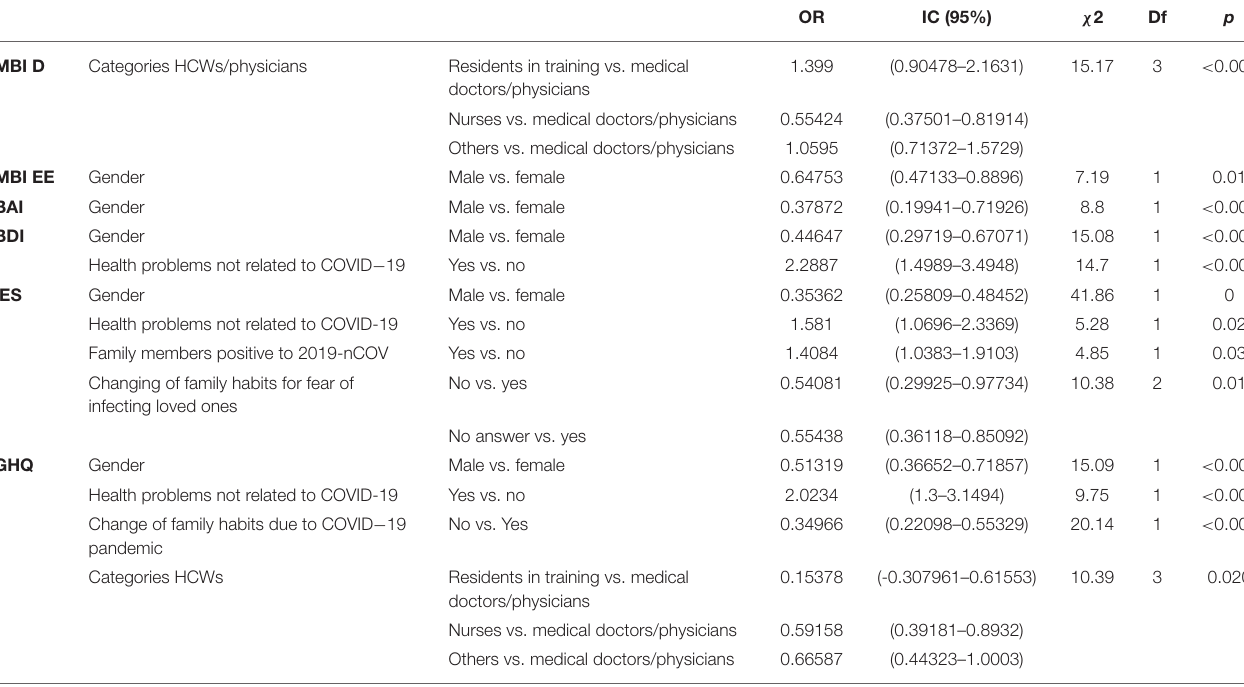
TABLE 7 | Results of the multivariate